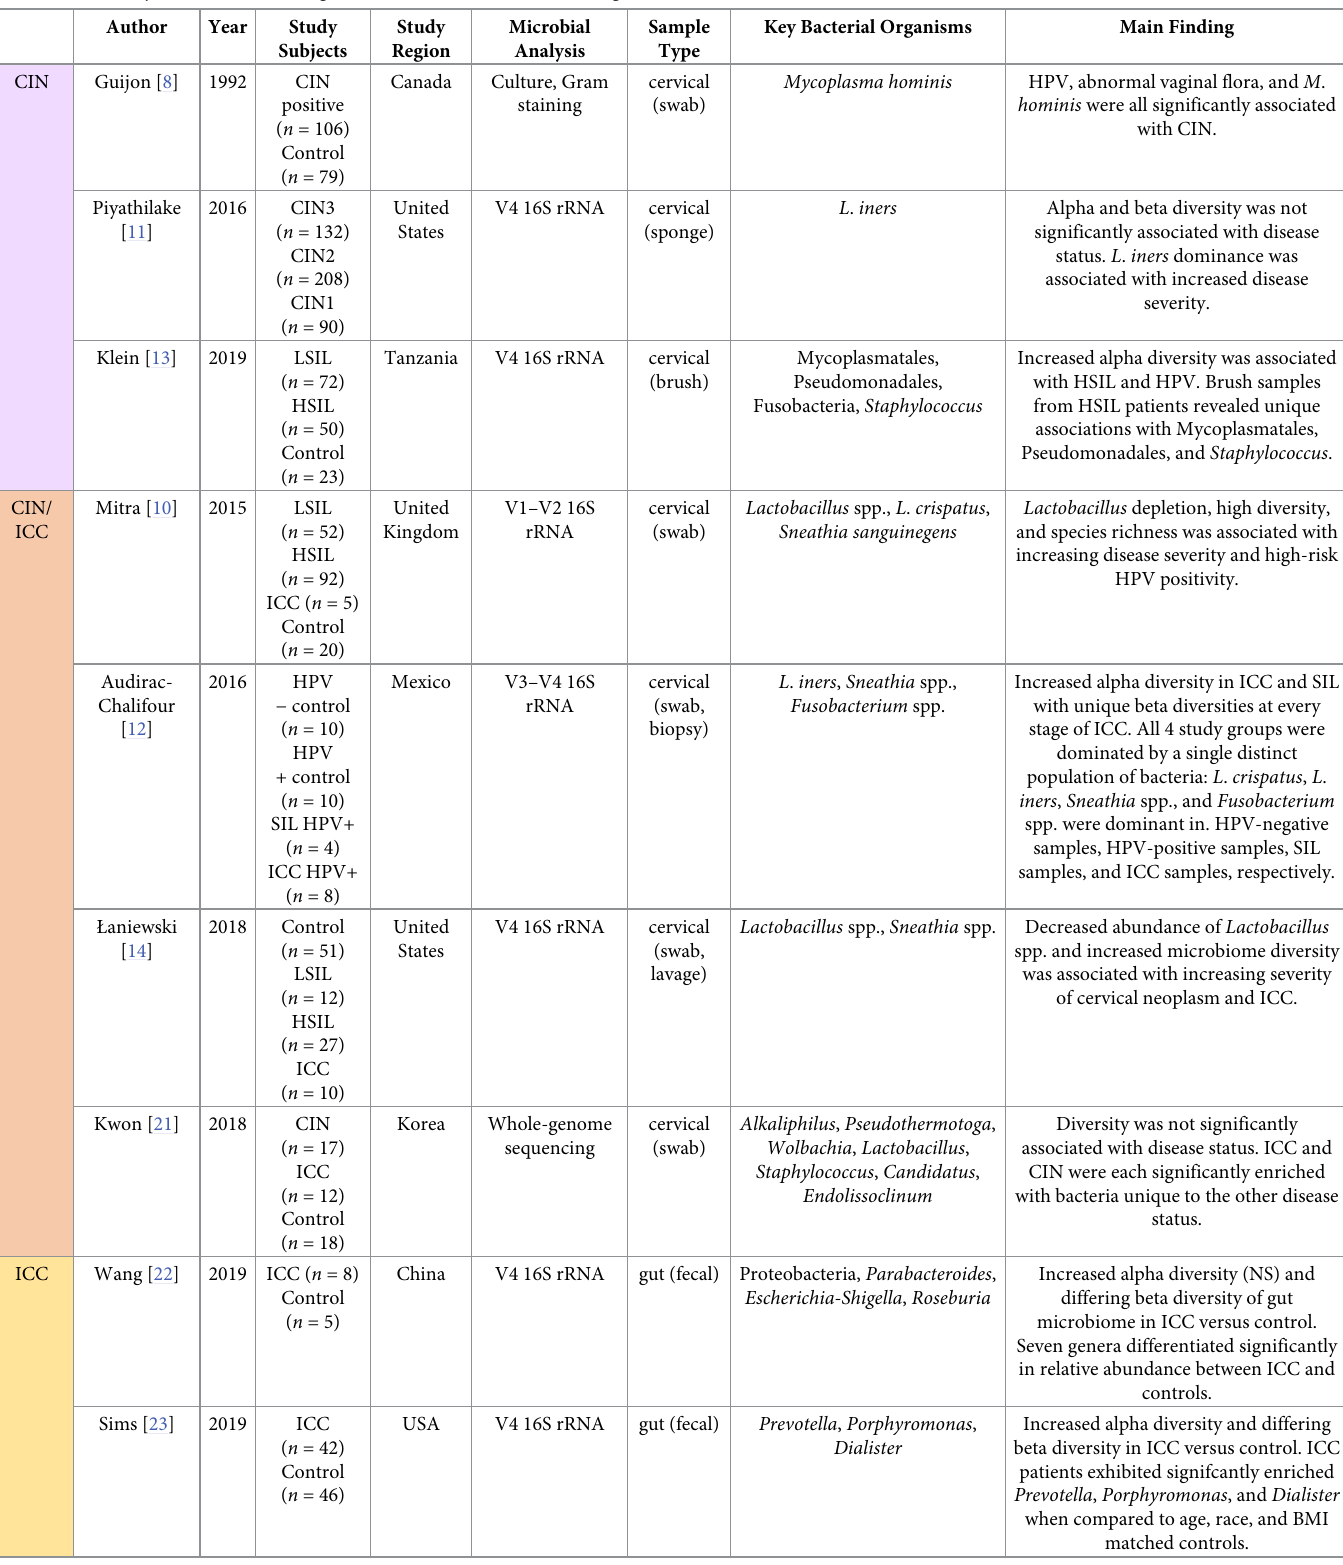
Table 1. Summary of articles discussing the microbiome and HPV